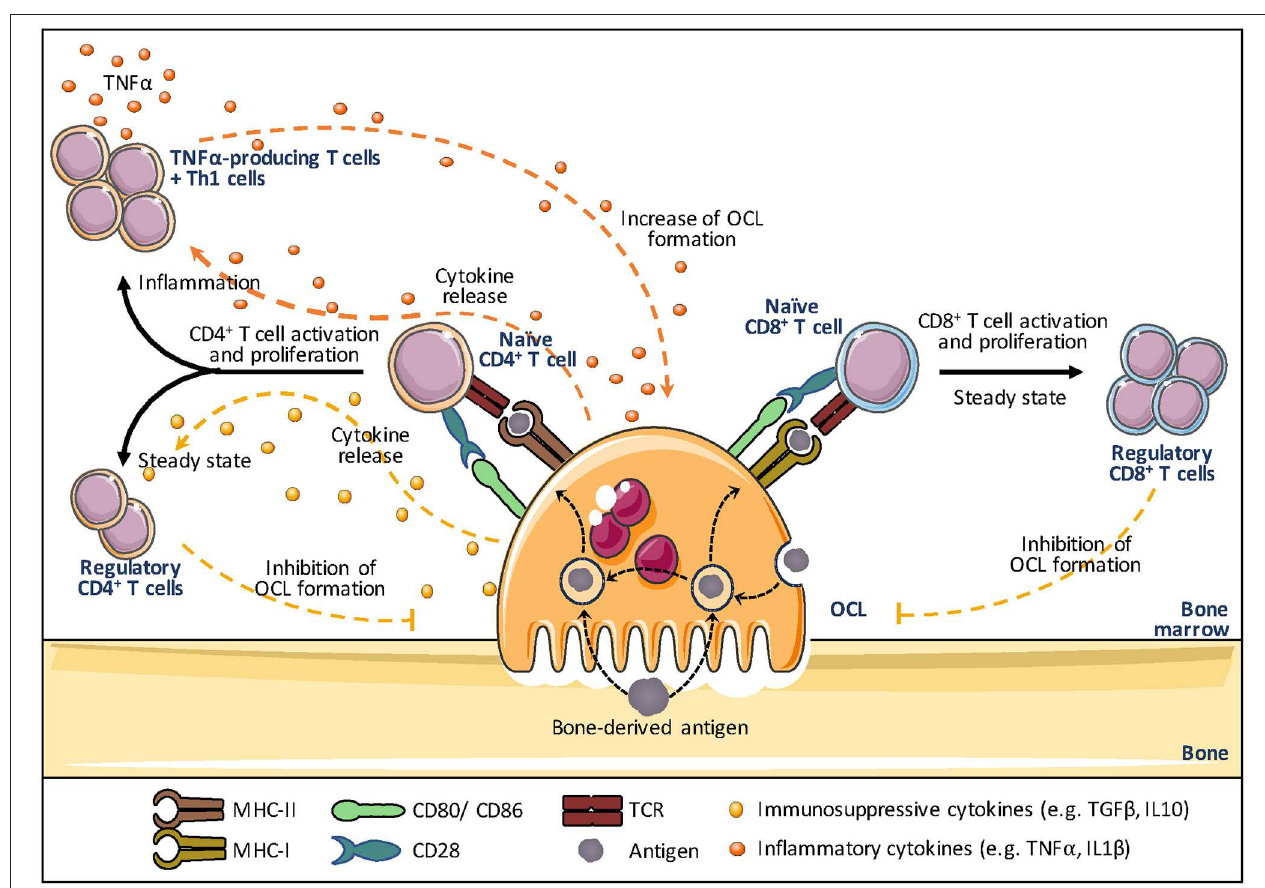
FIGURE 4 | Osteoclasts and antigen presentation. Osteoclasts (OCLs) function as antigen presenting cells (APCs). OCLs process and present antigens (coming from the bone through bone resorption or the bone marrow) in the form of short peptides bound to major histocompatibility complex (MHC)-I or MHC-II molecules. The T cell receptor (TCR) on CD8 + and CD4 + T cells binds to the MHC-I and MHC-II complex, respectively, to initiate T cell activation and to trigger TCR signaling. A key step in T cell activation represents the T cell binding to co-stimulatory molecules (e.g. CD80 and CD86 on OCLs and CD28 on T cells), as they determine the functional outcome of the T cell receptor signaling. Subsequently, OCLs start secreting cytokines that control the differentiation of activated T cells. In steady state, OCLs produce mainly IL-10 and TGF β and induce regulatory T cells (Treg) that are responsible for immunosuppressive responses and inhibit OCL differentiation, creating a negative feedback down regulating both inflammation and bone resorption. In contrast, in inflammation, OCLs induce effector TNF α -producing T cells that promote inflammation and may stimulate osteoclastogenesis thanks to their TNF α production. The effect of OCLs on CD8 + T cells in inflammatory conditions has not been explored